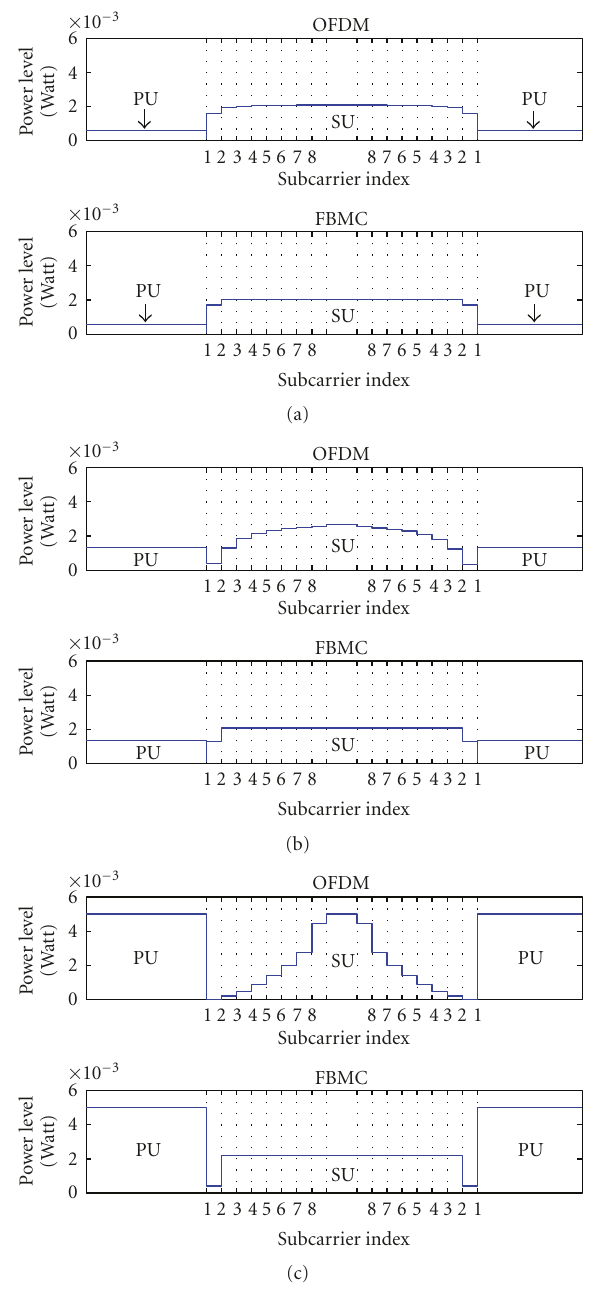
Figure 6: Three typical channel realizations of single-user case with F = 18, λ = 0 . 5, D = 0 . 2km, and P th = 36mWatt: (a) D SU → SBS